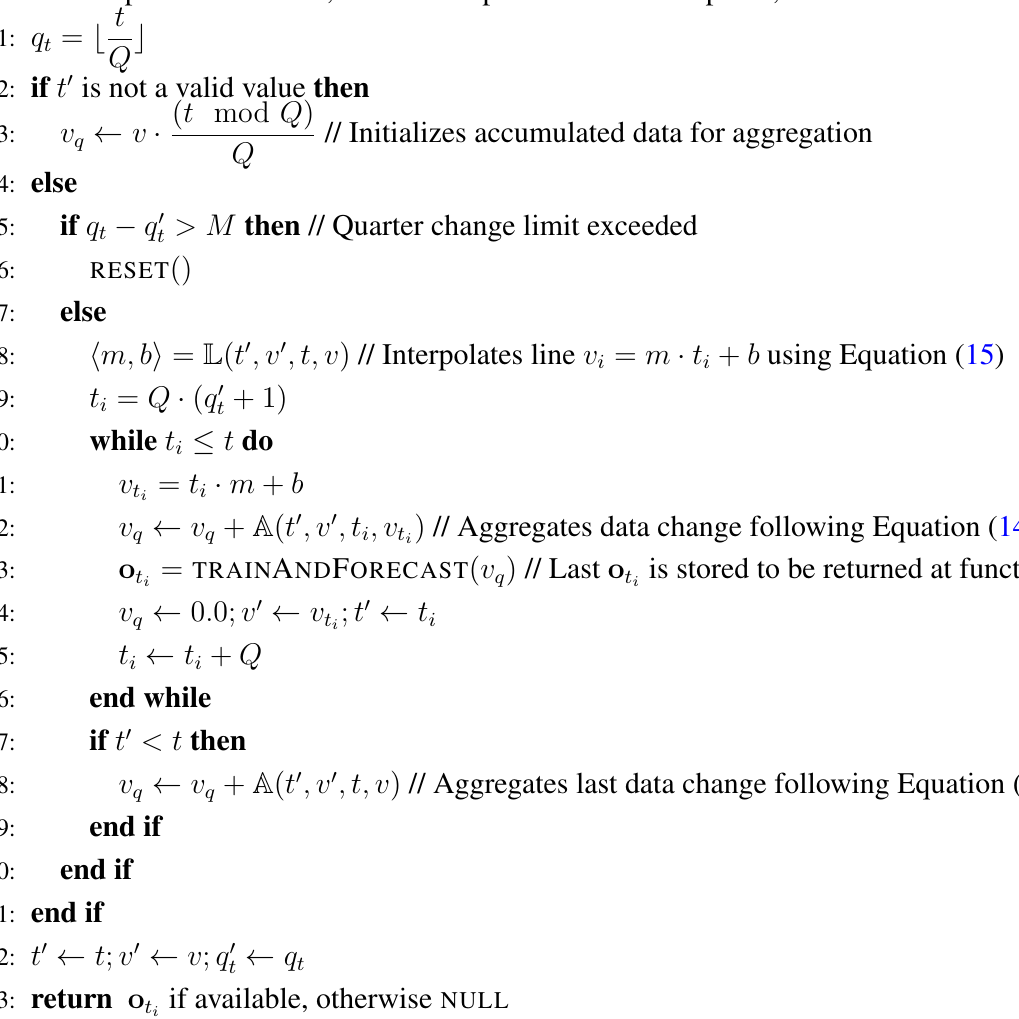
Algorithm 2 PROCESS S AMPLE O N L INE ( v , t